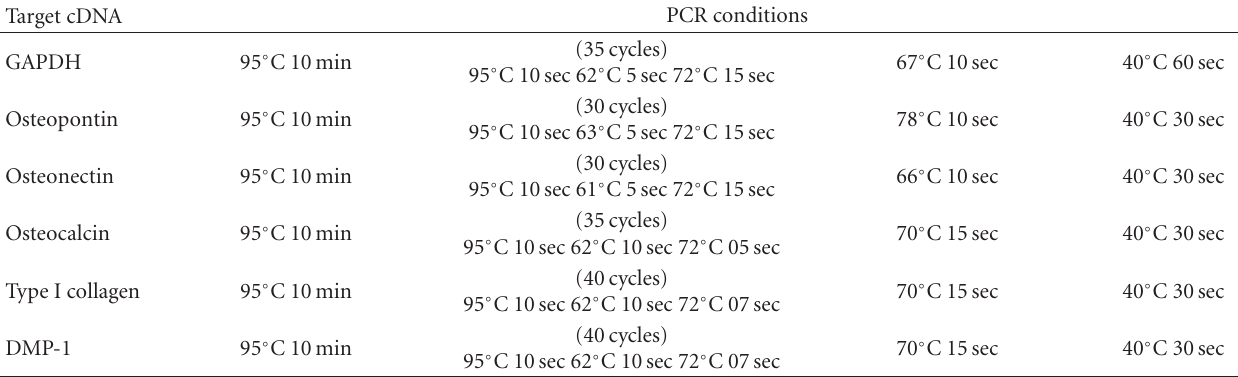
Table 2: Conditions of quantitative PCR using